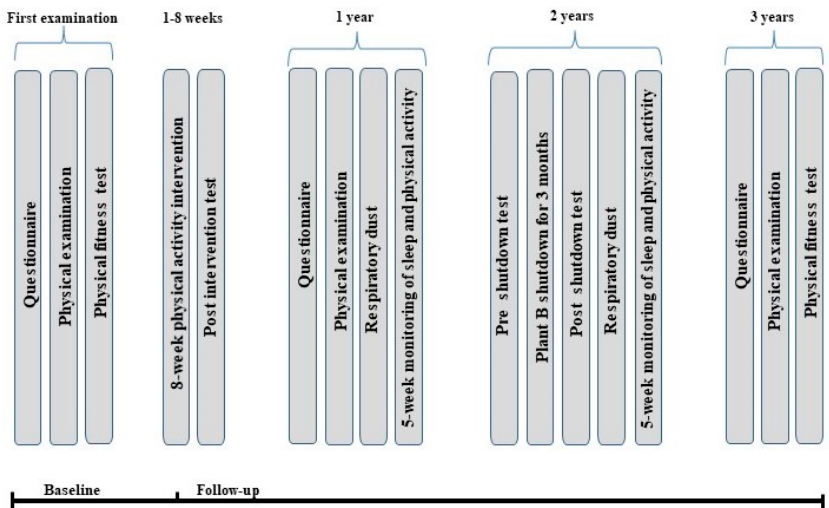
Figure 1. Time line for data collection .